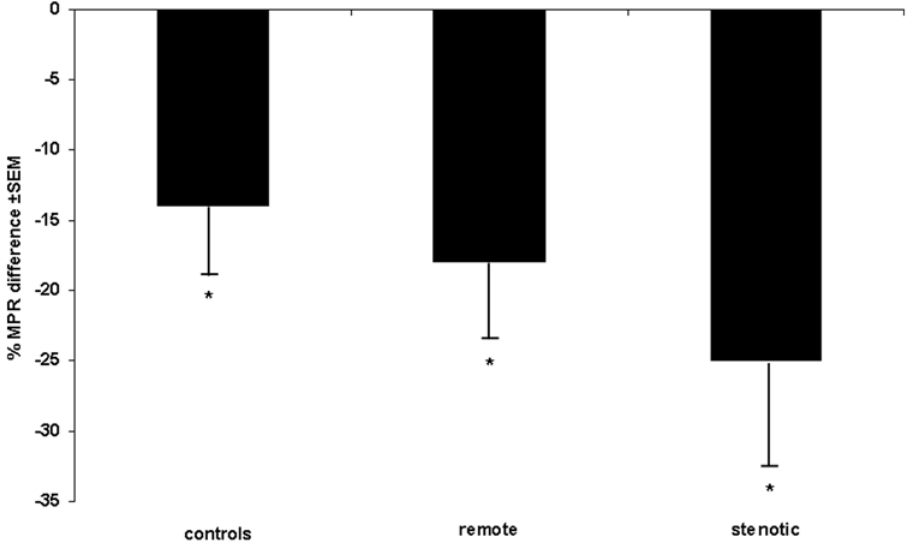
Figure 2. Myocardial perfusion reserve: effects of caffeine. Caffeine decreases myocardial perfusion reserve. This effect was most pronounced in stenotic segments of CAD patients. * P , 0.05 for the comparison versus